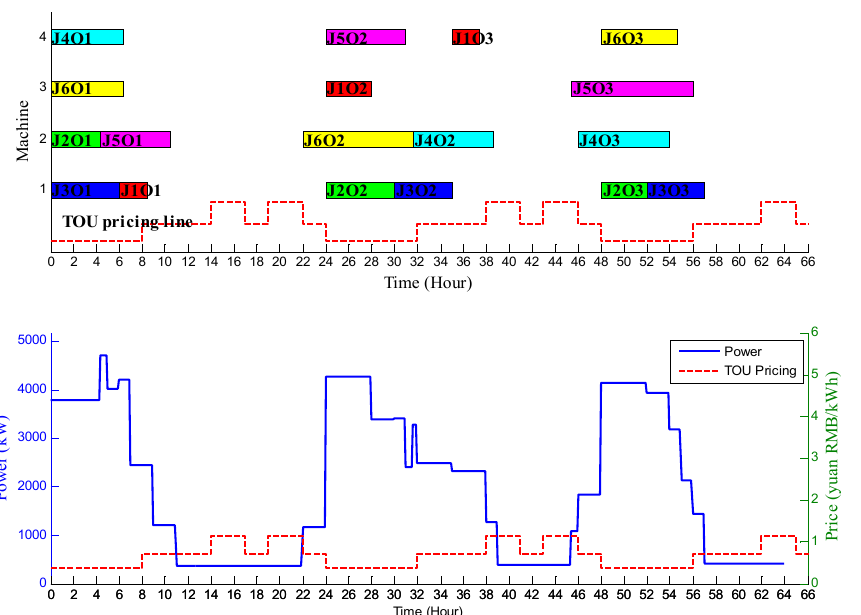
Figure 8. Gantt and power charts of the optimal solution to configuration C4 × 6&EXS.